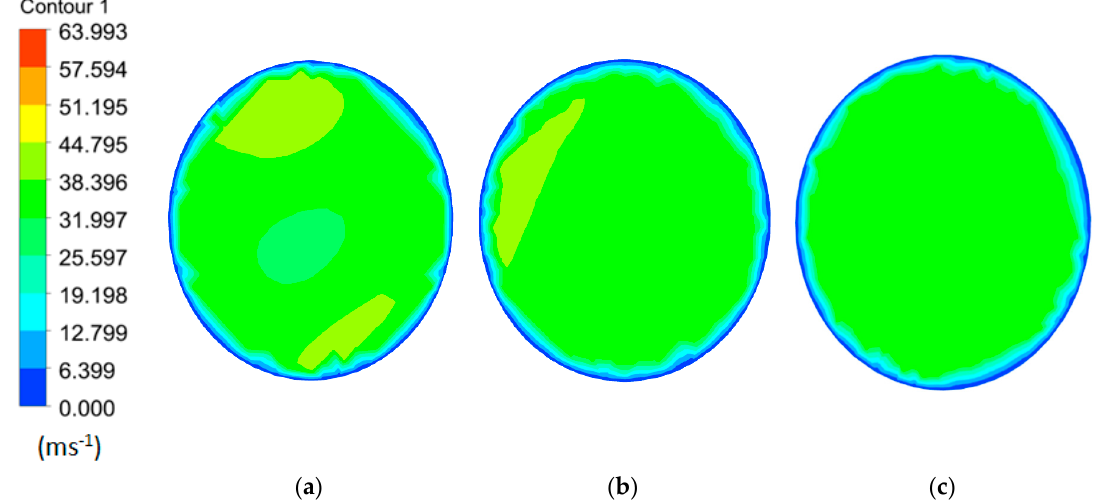
Figure 6. Velocity contour maps at the inlet of catalyst inlet. ( a ) Line (LM) mixer, ( b ) swirl (SM) mixer, ( c ) and two mixers (LSM).